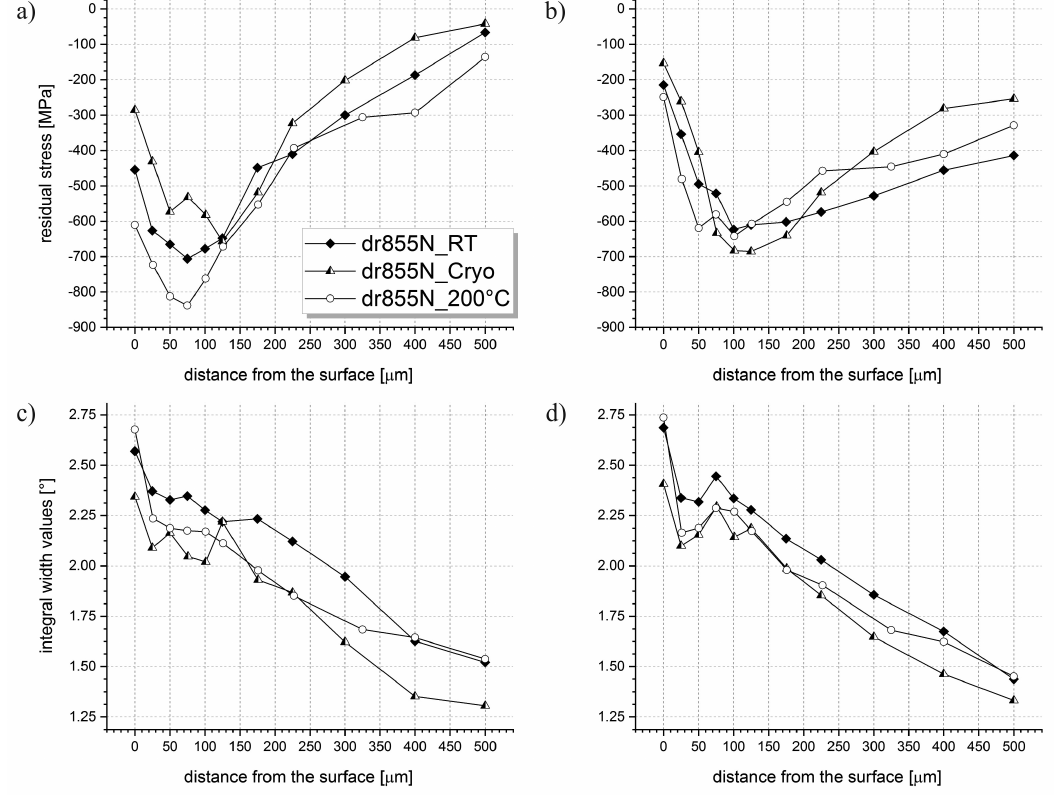
Figure 8. Residual stress profiles and integral width values in longitudinal ( a + c ) and circumferential ( b + d ) direction plotted as a function of deep rolling temperature at constant deep rolling